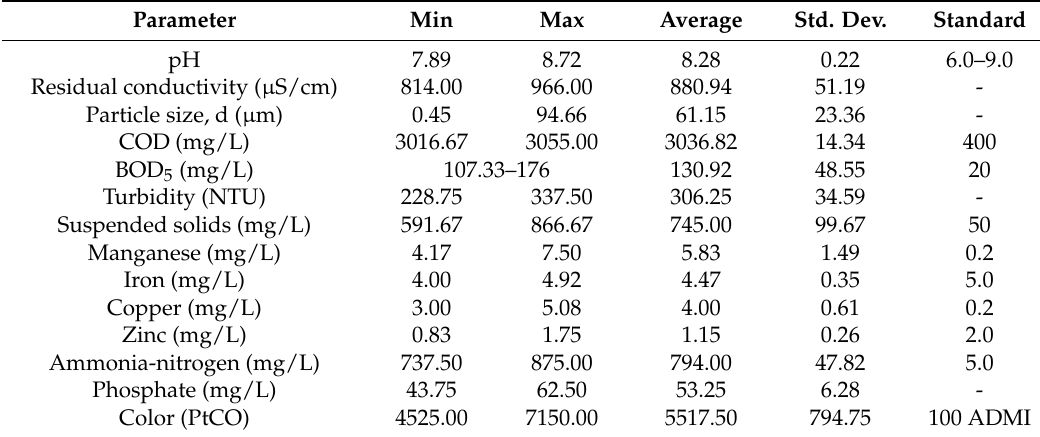
Table 1. Characteristics of raw